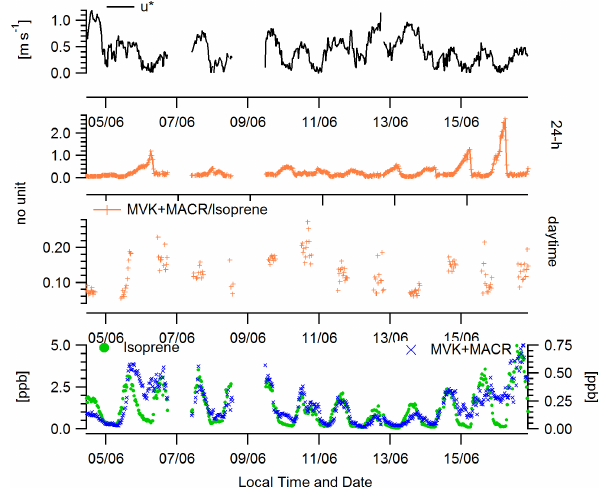
Figure 6. Time series of MVK + MACR and isoprene concentra- tions, [MVK + MACR]/isoprene ratio (daytime data set and whole data set) along with friction velocity above the canopy of the O 3 HP.